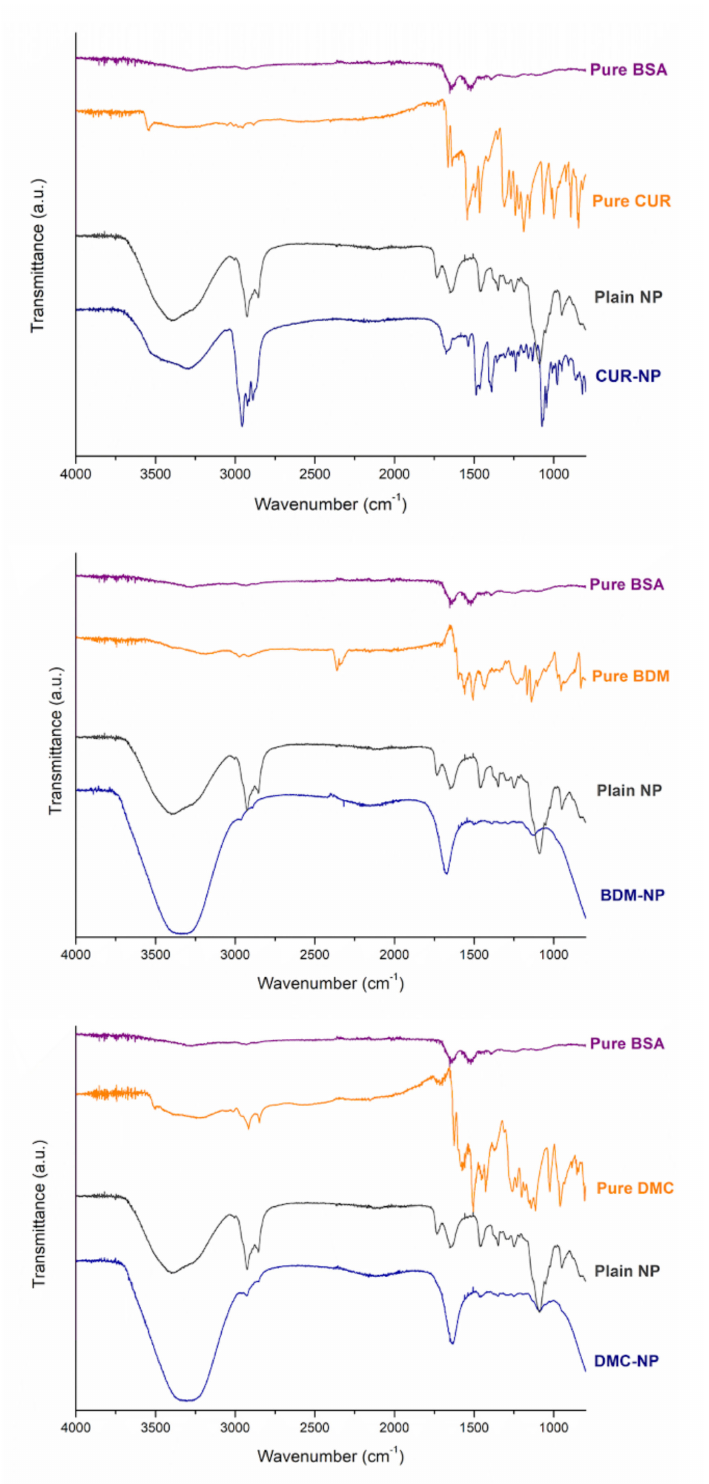
Figure 2. FT-IR spectra of CUR-, DMC-, and BDM-loaded BSA-NP, plain BSA-NP, and free CUR, DMC, and